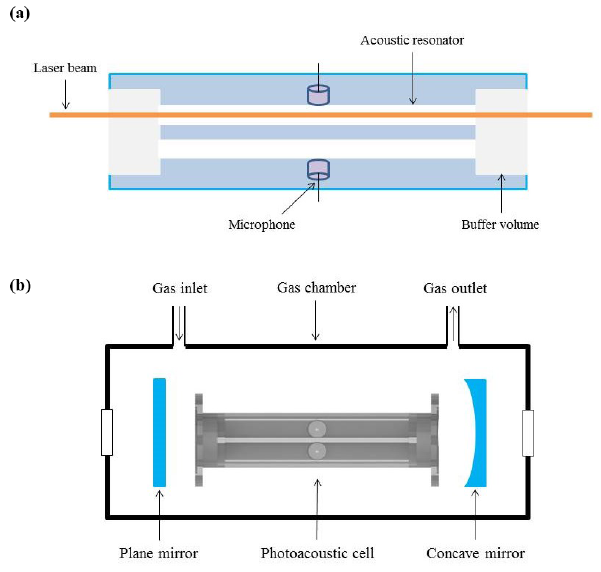
Figure 3. (a) Schematic diagram of the differential photoacoustic cell. (b) Schematic diagram of the cavity-enhanced photoacoustic module